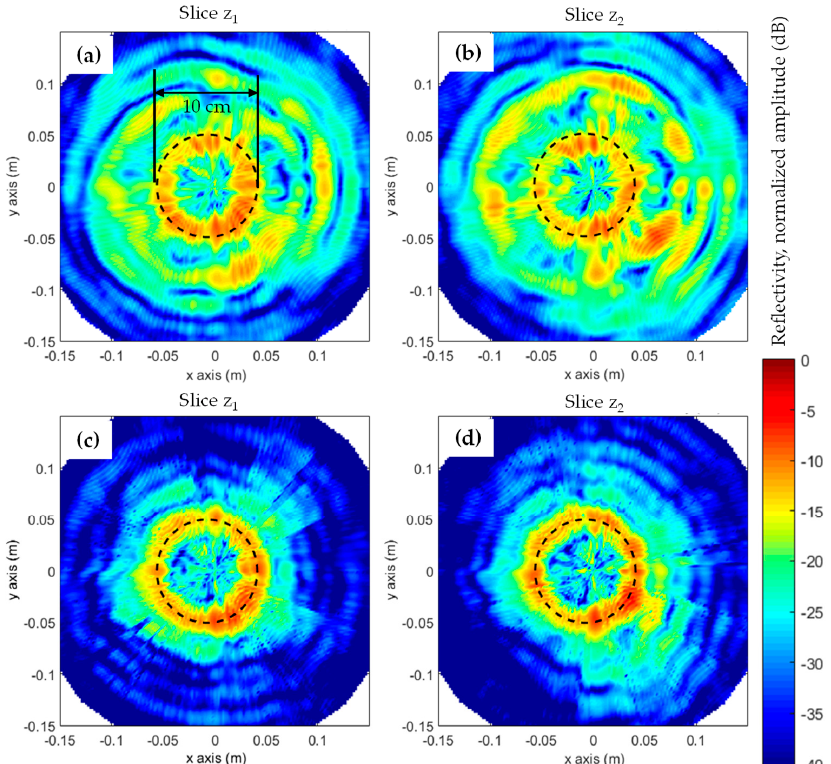
Figure 7. Polar representation of the reflectivity for two different XY slices (z 1 = − 12 cm and z 2 = − 5 cm with respect to the top of the wax candle). ( a , b ) Without dielectric delay correction. ( c , d ) After dielectric delay correction, considering ε r,est = 2.3. Dashed line represents the true contour of the wax candle.